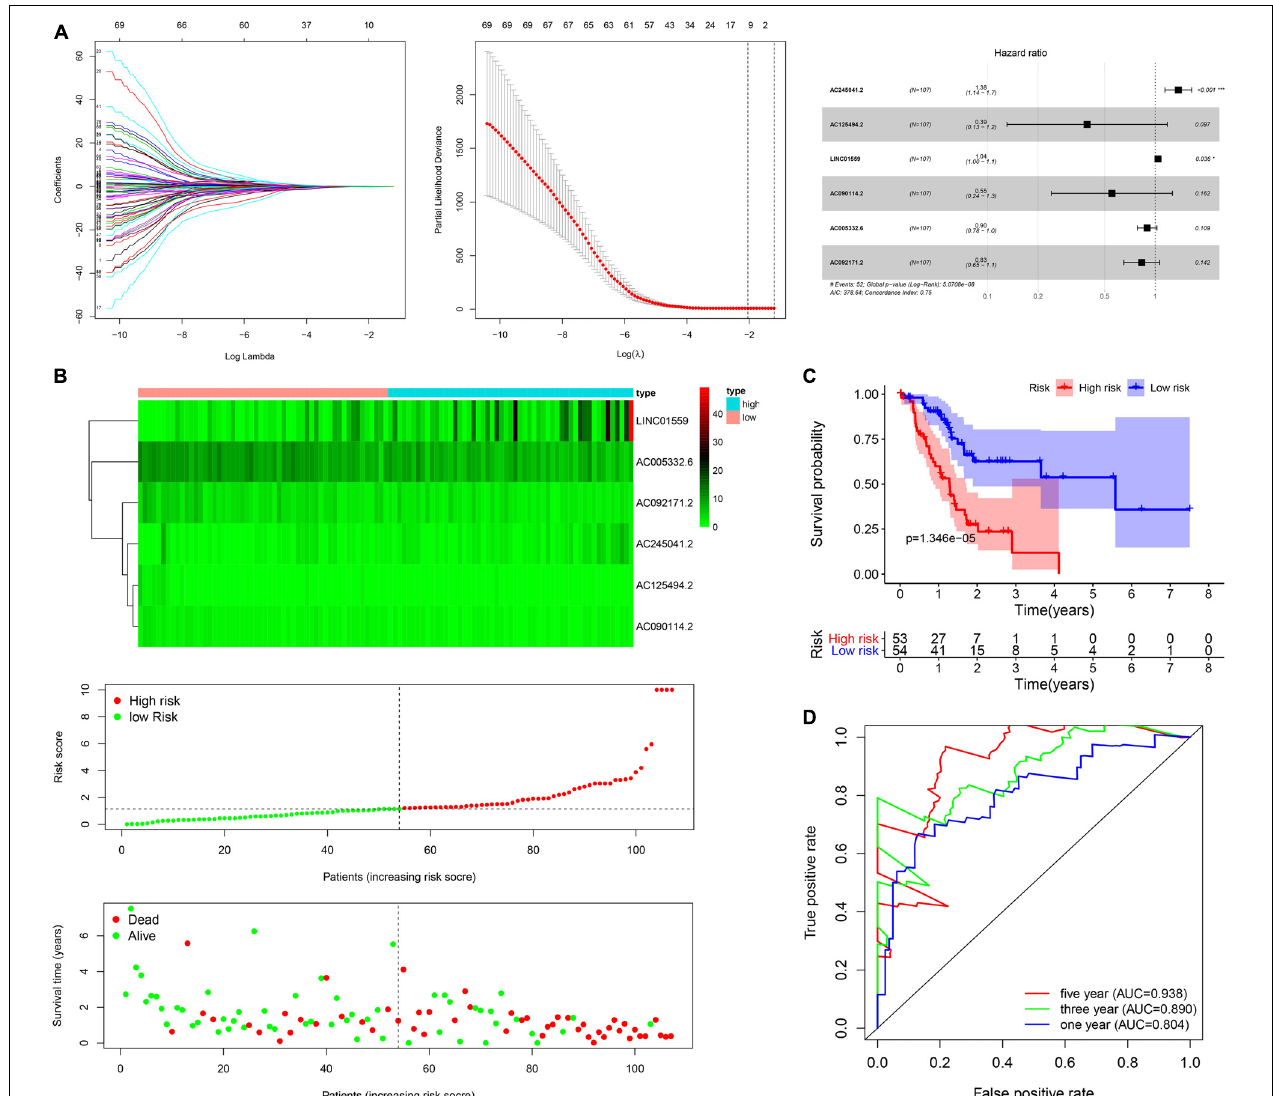
FIGURE 1 | Construction of the autophagy related lncRNAs signature in training cohort. (A) The procedure of the construction of the SRGs signature, including univariate Cox regression analysis (left), LASSO penalized Cox regression analysis (middle) and multivariate Cox regression analysis (right). (B) Correlation between the prognostic signature and the overall survival of patients. The distribution of selected ARlncRNAs (upper), risk score (middle) and survival time (below). (C) Kaplan-Meier survival analysis of high-risk and low-risk risk group. (D) Receiver operating characteristic (ROC) curves for 1, 3, and 5 years survival (* p < 0.05; *** p < 0.001; ns, not